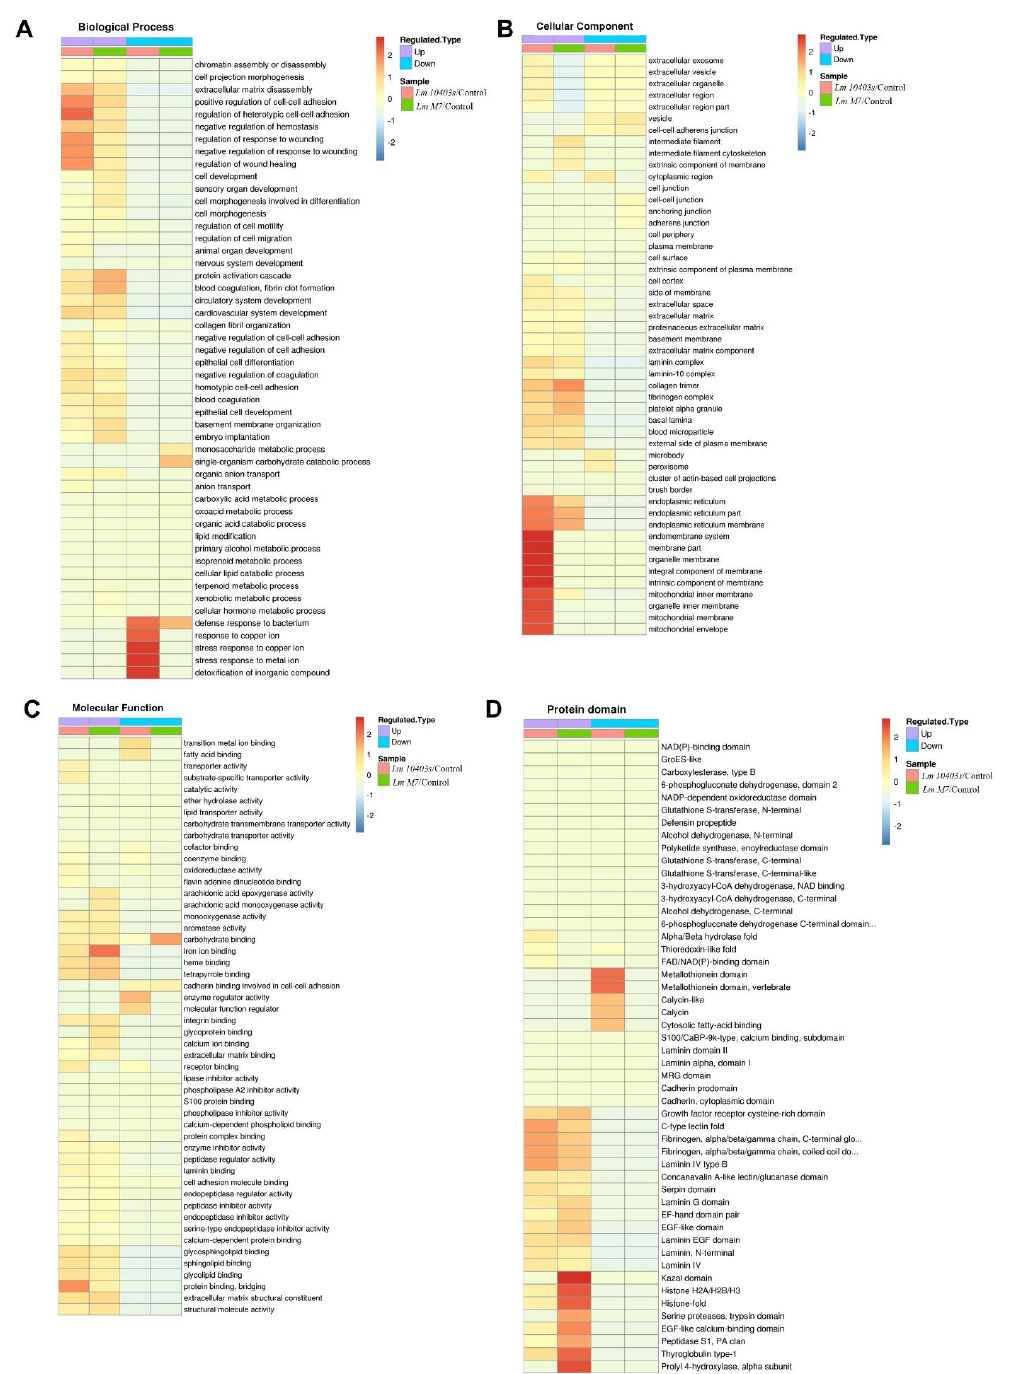
Figure 5. GO and protein domain enrichment analysis of the DEPs. Heatmaps show the enrichments of the DEPs in different comparisons with GO annotation belonging to biological processes ( A ), cellular components ( B ), and molecular function ( C ). ( D ) Significantly enriched protein domains of the DEPs.